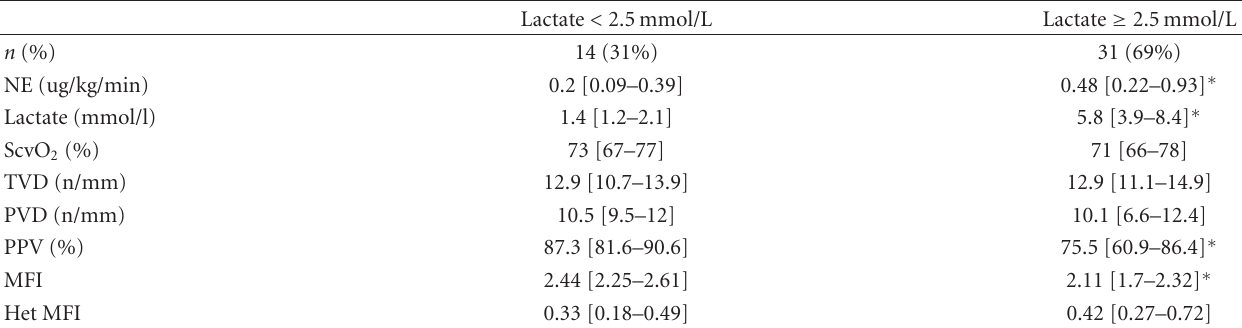
Table 4: Hemodynamic, perfusion and microcirculatory parameters in 45 patients evaluated with sublingual SDF videomicroscopy. Lactate <